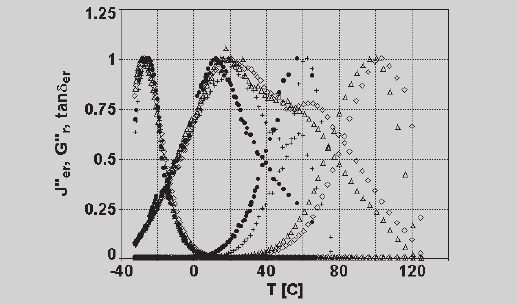
Figure 10 (left): Isochrones, 10 rad/s; relative modified loss compliance and loss tangent, relative loss modulus ( • Base, + 4% EVA, (cid:3)(cid:3) 4% SBS l, ◊ 4% SBSr). Figure 11: Isochrones, 10 rad/s;